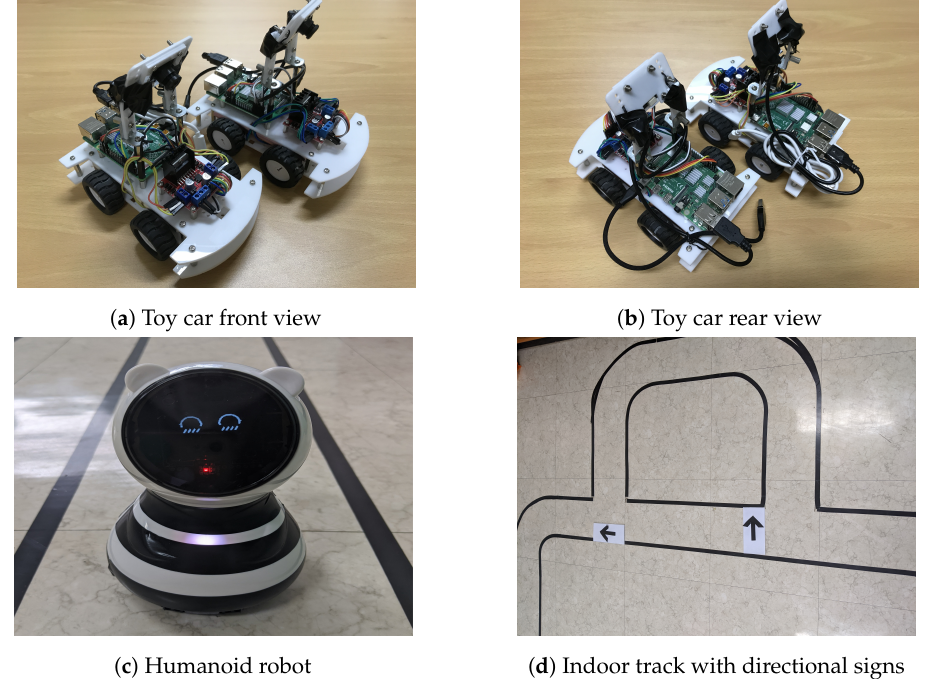
Figure 7. Toy cars with Raspberry Pi v4 and an L298N motor drive shield, a humanoid robot, were used for the experiments on an indoor track with directional